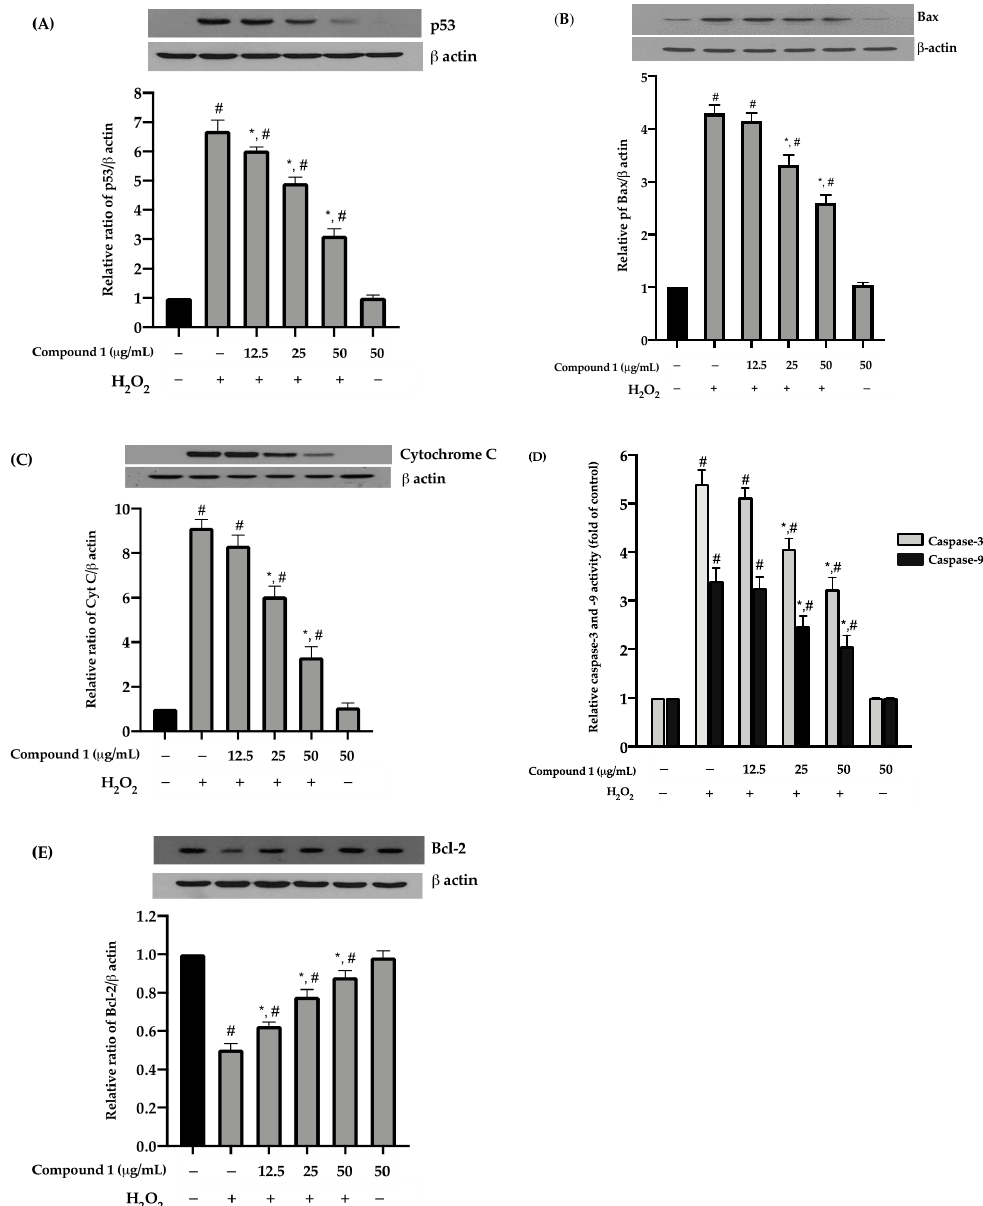
Figure 5. Effect of compound 1 on the expression of ( A ) p53, ( B ) Bax, ( C ) cytochrome C, ( D ) caspase-3 and -9, and ( E ) Bcl-2 in HaCaT keratinocytes induced oxidative stress with H 2 O 2 . Cells were pre-treated with various concentrations of compound 1 (12.5, 25, and 50 µg/mL) for 24 h exposed to 500 µmol/L of H 2 O 2 for 1h. Graphs represent the mean ± SD values of four replications. * p < 0.05 indicates significant differences from the H 2 O 2 stimulation group, # p < 0.05 indicates significant differences from the control group.